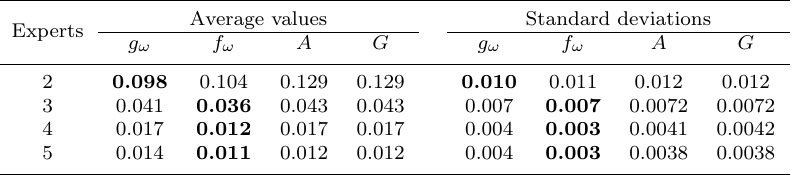
Table 9. Average values and standard deviations of error probabilities in ranking alterna- tives for different aggregation functions. Matrix ˜ P 2 (“very good” experts). Average values Standard deviations Experts g